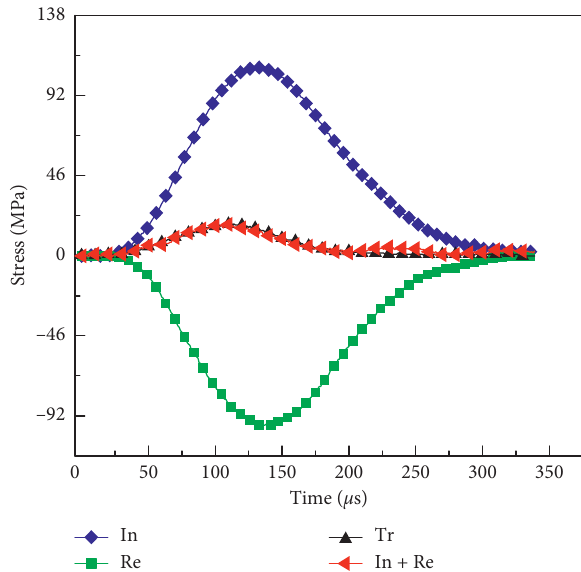
Figure 6: The verification of stress equilibrium in dynamical test (In, Re, and Tr refer to incident, reflected, and transmitted waves,